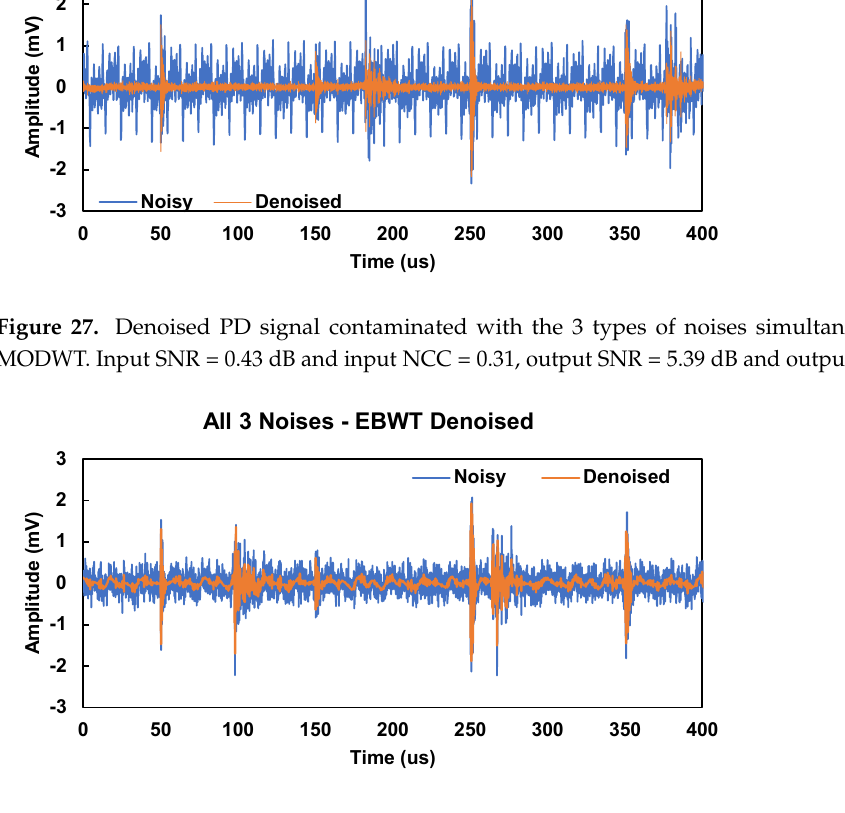
Figure 28. Denoised PD signal contaminated with the 3 types of noises simultaneously using EBWT. Input SNR = 1.23 dB and input NCC = 0.49, output SNR = 2.98 dB and output NCC =